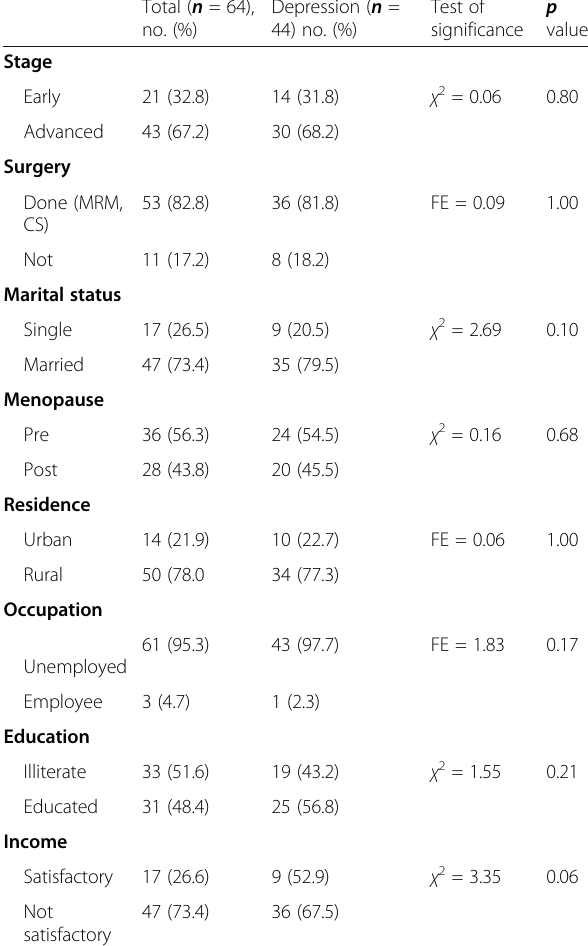
Table 3 Relationship between the total number of cases and patients with depression as regarding patient ’ s and disease ’ s